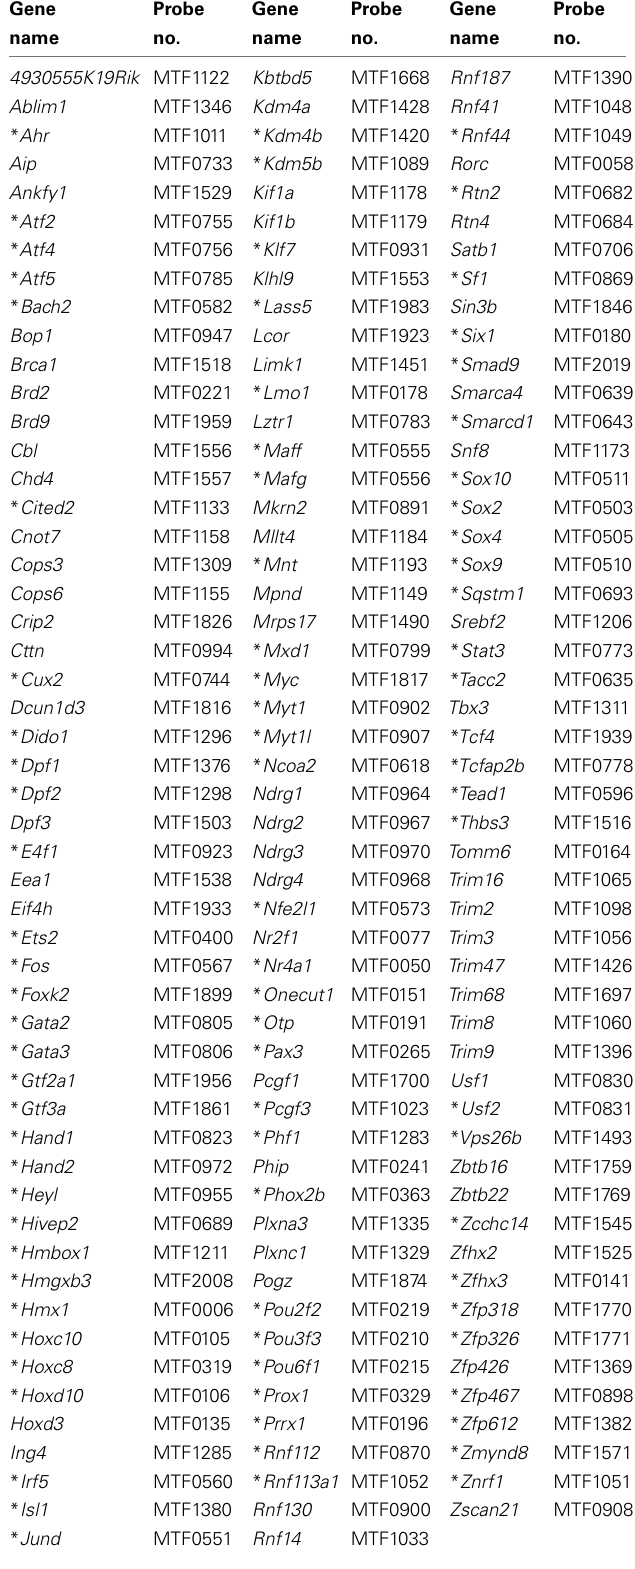
Table 1 | Genes detected in pelvic ganglia at 15.5dpc by whole-mount in situ